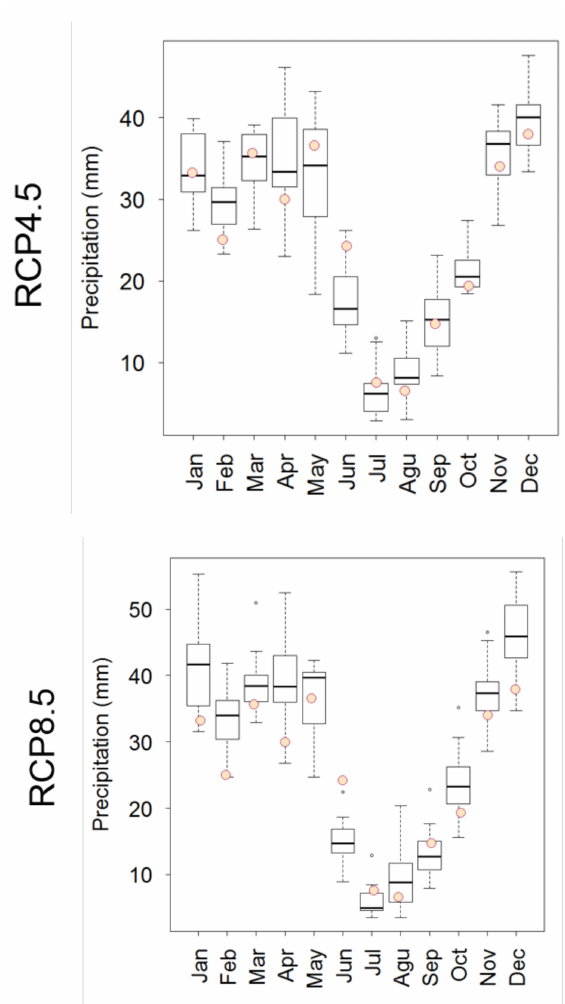
Figure 3. A boxplot of monthly climate variables over 11 GCMs, using only precipitation as an example. The boxplot of the other 12 variables is included in the Appendix A. The circles indicate the recent past (PAST) monthly precipitation. The large variance indicates that an ensemble of climate realizations is necessary to capture the variations of future climate